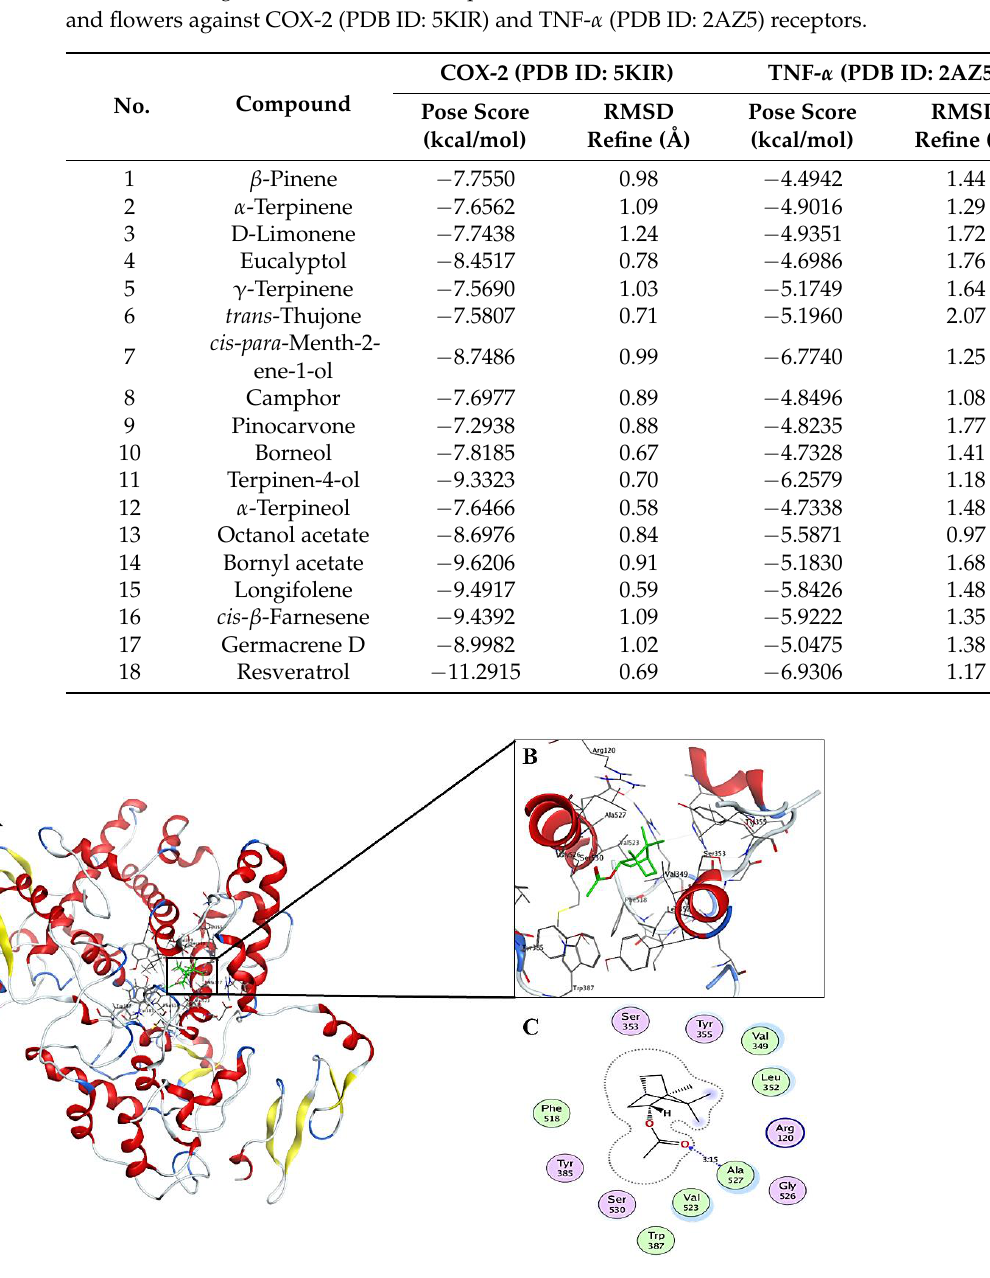
Figure 5. 2D and 3D interactions complex of compound 14 (bornyl acetate) with the COX-2 receptor. ( A ) receptor ligand complex, ( B ) 3D interactions of ligand with the active site, ( C ) 2D interactions of ligand with the active site.